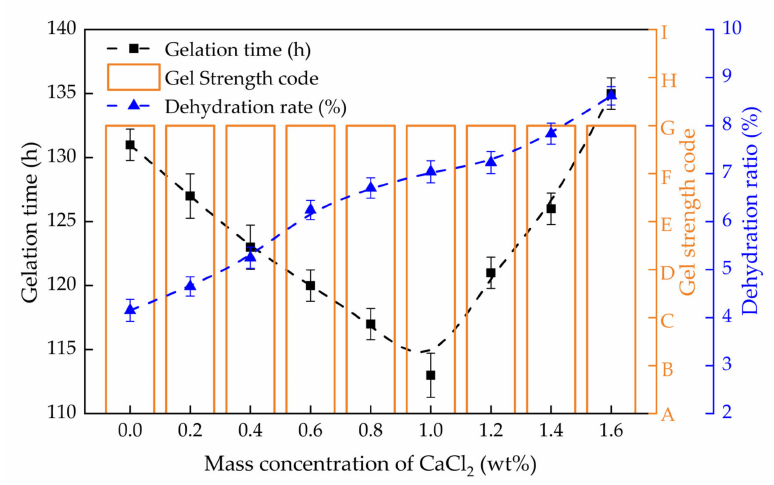
Figure 10. Gelling performance of PHRO in different concentrations of CaCl 2 solution.